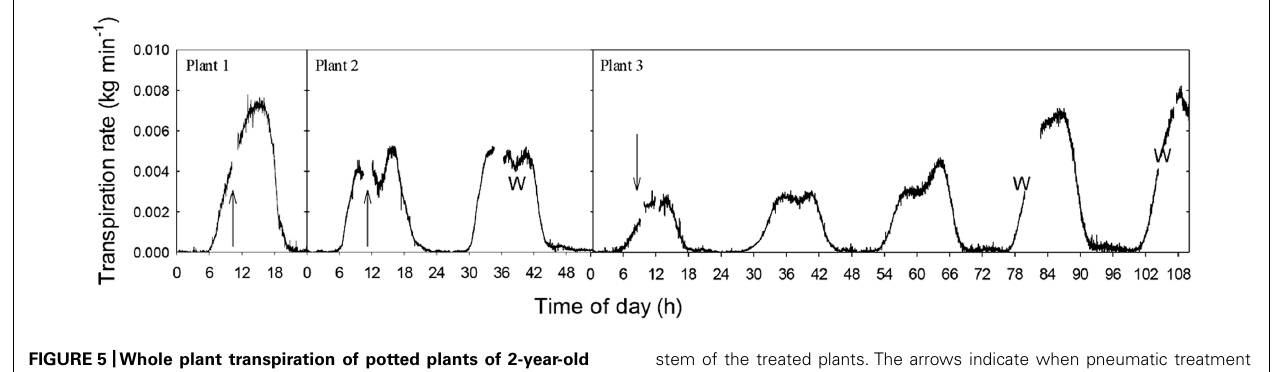
stem of the treated plants. The arrows indicate when pneumatic treatment was applied. The W represents when the plants were removed from the balance for